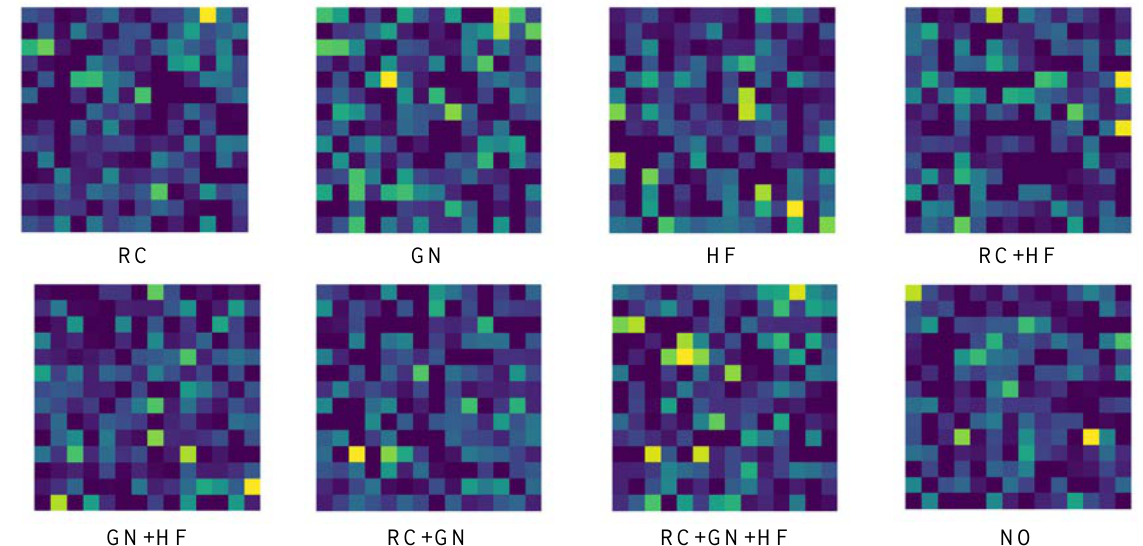
Figure 6. Attention mapping of different image enhancement methods.